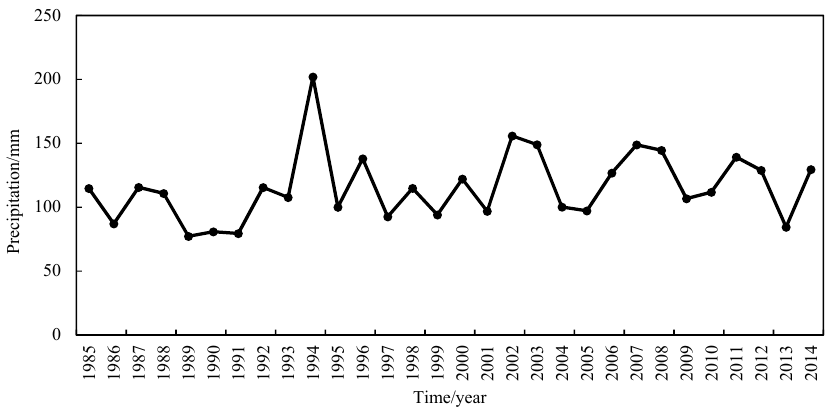
Figure 2. Precipitation from 1985–2014 in Minqin County.